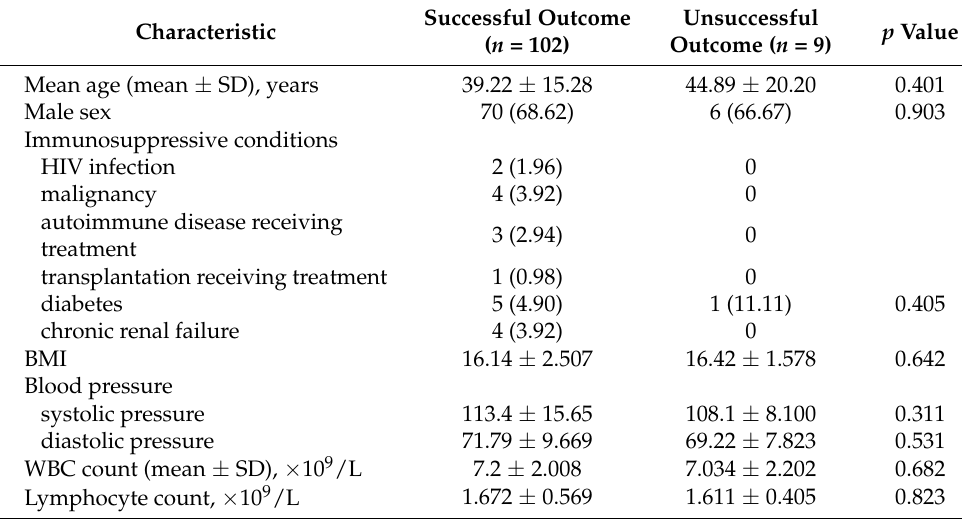
Figure 1. Flow diagram summarizing patient recruitment, exclusion criteria, and the patient groups. Table 1. Demographic and clinical characteristics of pulmonary TB patients in different outcome groups.